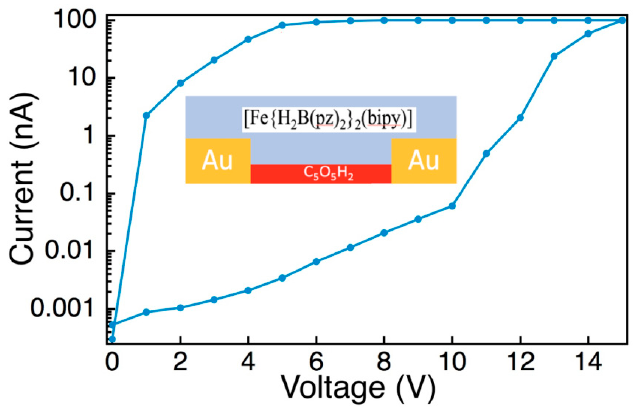
Figure 6. The “zoomed” conductance change of a 20 nm [Fe{H 2 B(pz) 2 } 2 (bipy)] thin film deposited on croconic acid thin film, showing a high on/off ratio.